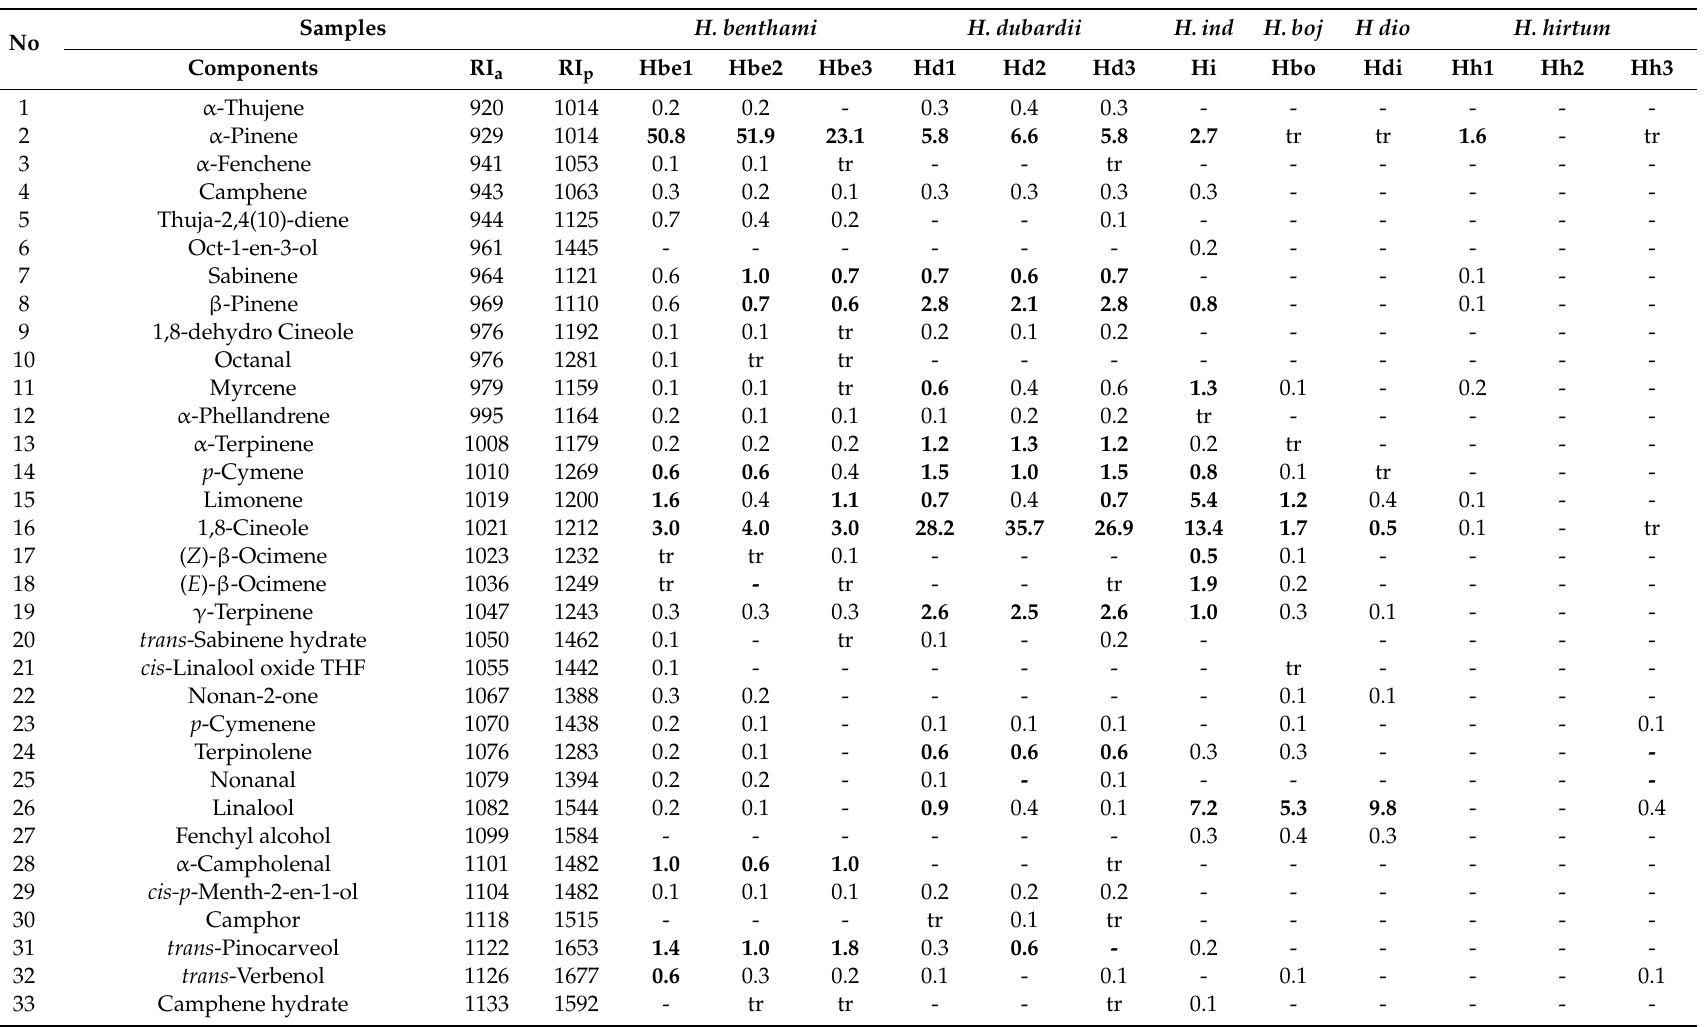
Table 1. Chemical composition of six Helichrysum essential oil